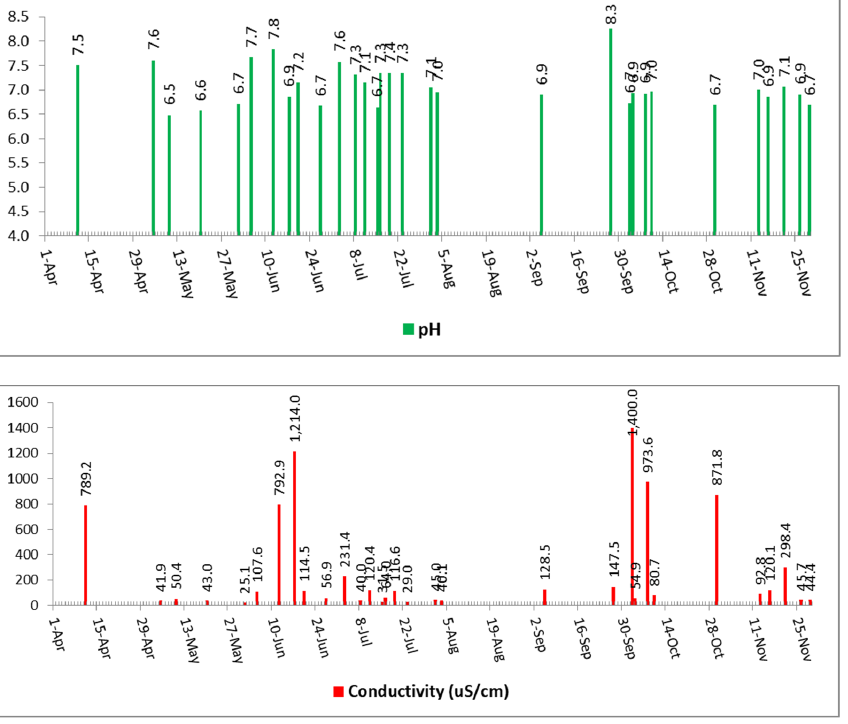
Figure 2. pH and conductivity ( μ S/cm) in rainwater determined for each major precipitation (n = 31) recorded between April and November 2019 in Targoviste city, Romania.